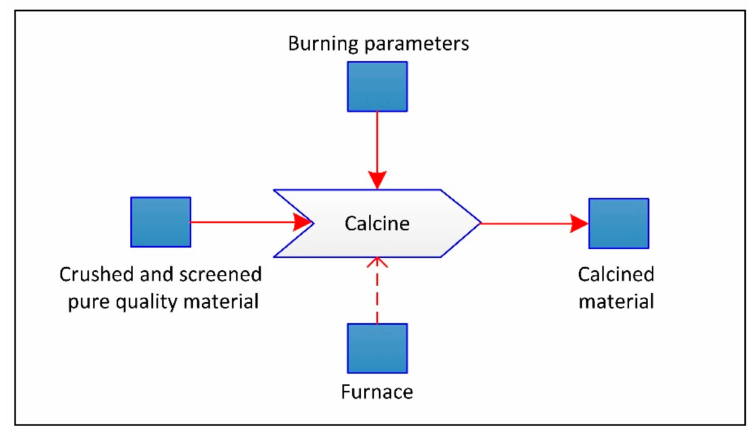
Figure 7. Decomposition of the Calcined material box.